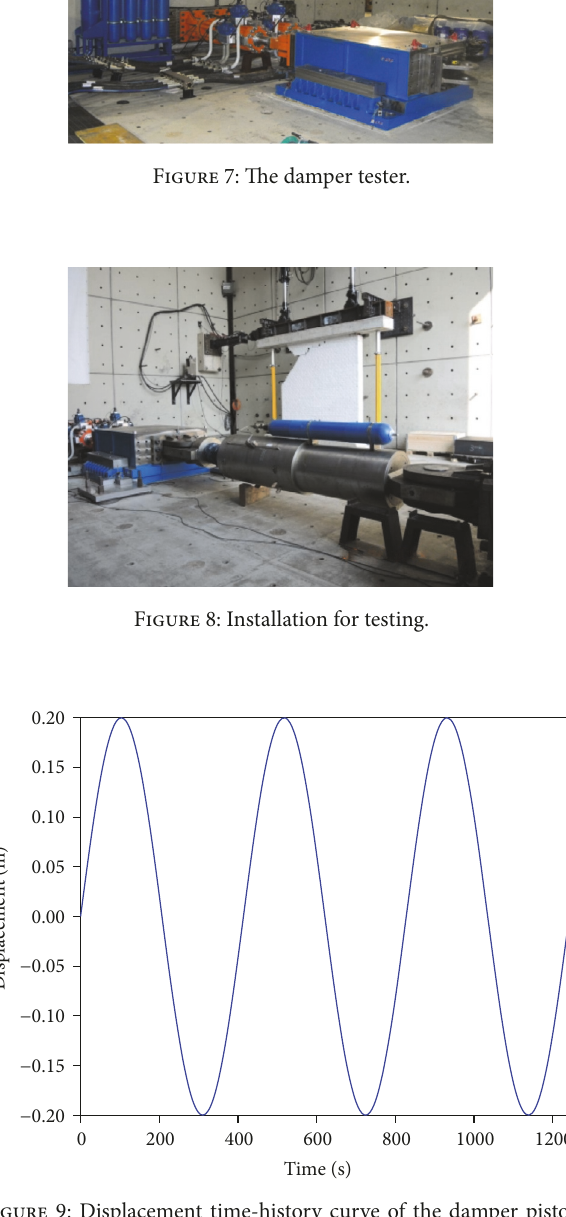
Figure 9: Displacement time-history curve of the damper piston pod.